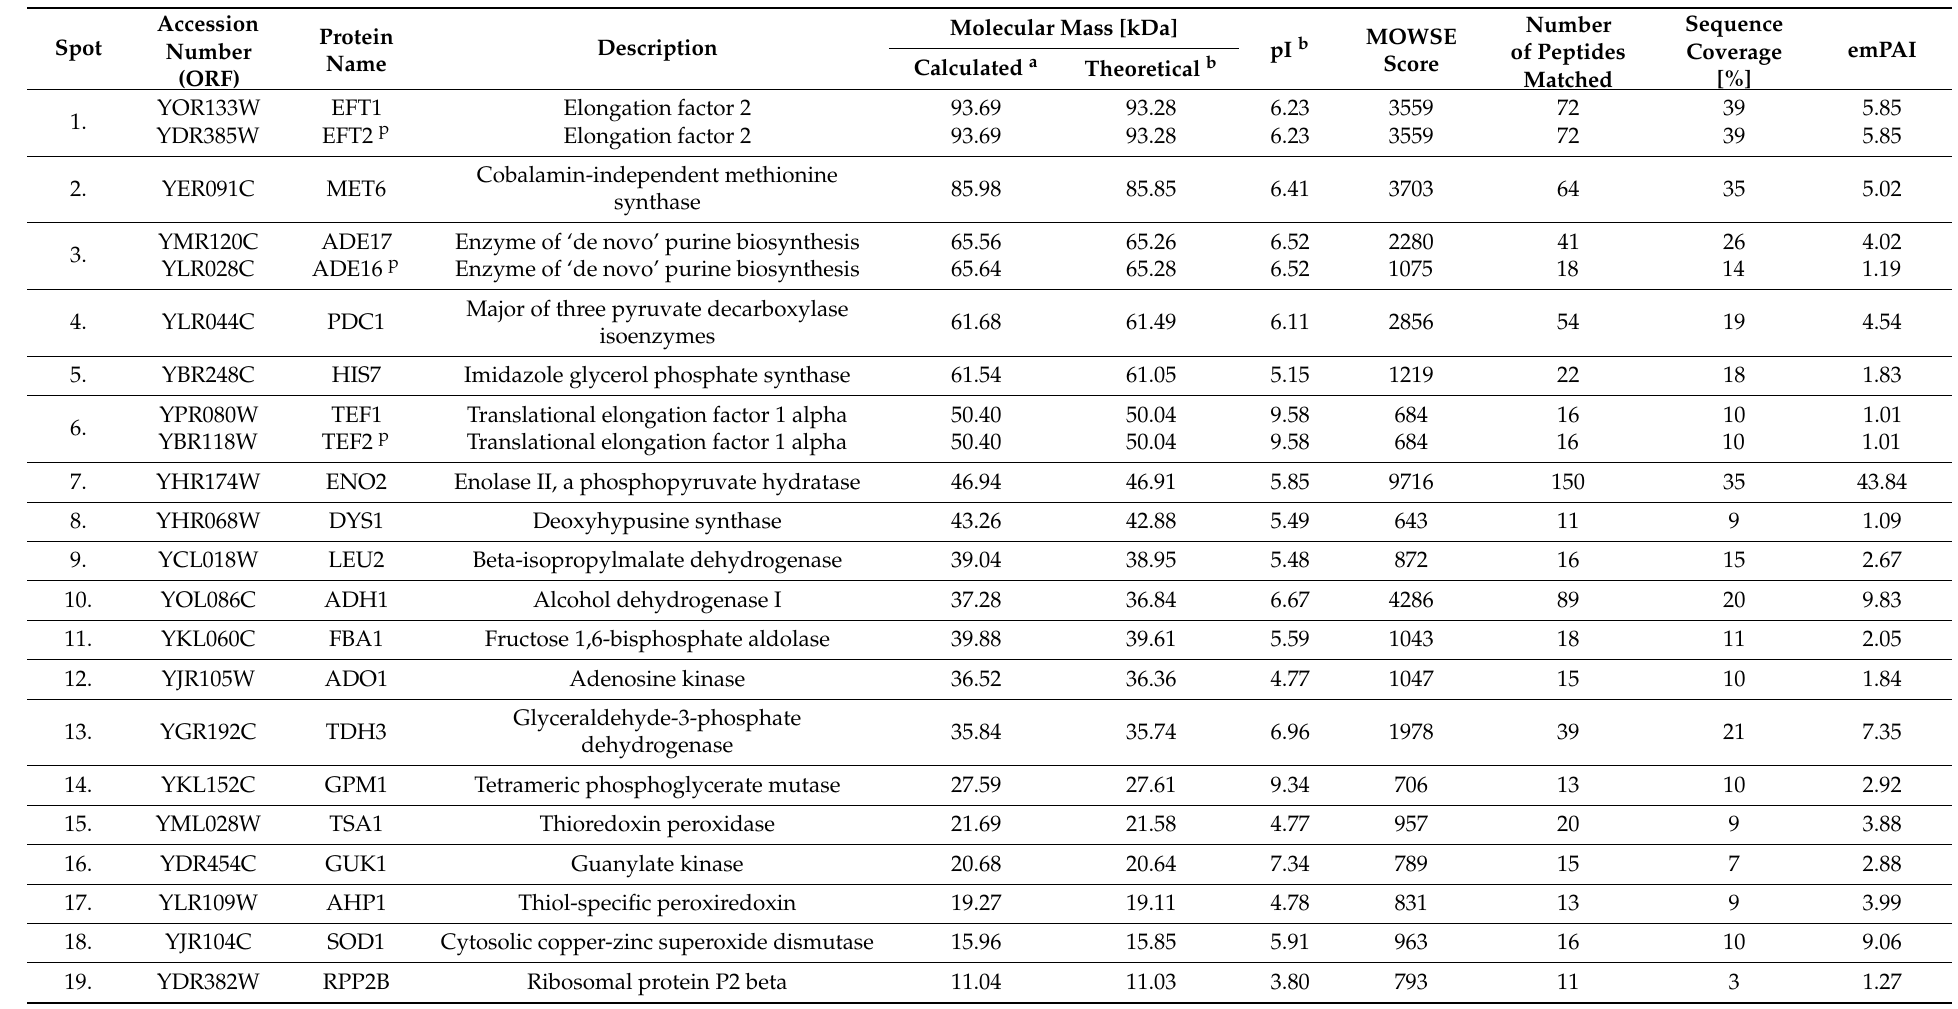
Table 1. List of proteins identified by mass spectrometry